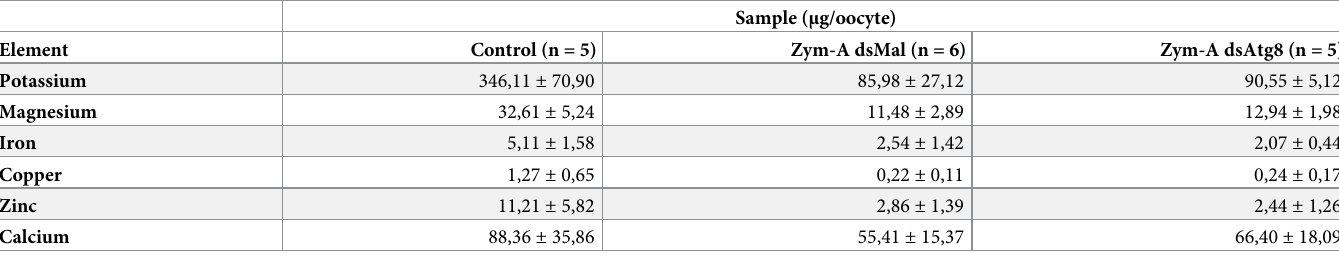
Table 2. Elemental quantification using Inductively coupled plasma mass spectrometry (ICP-MS).